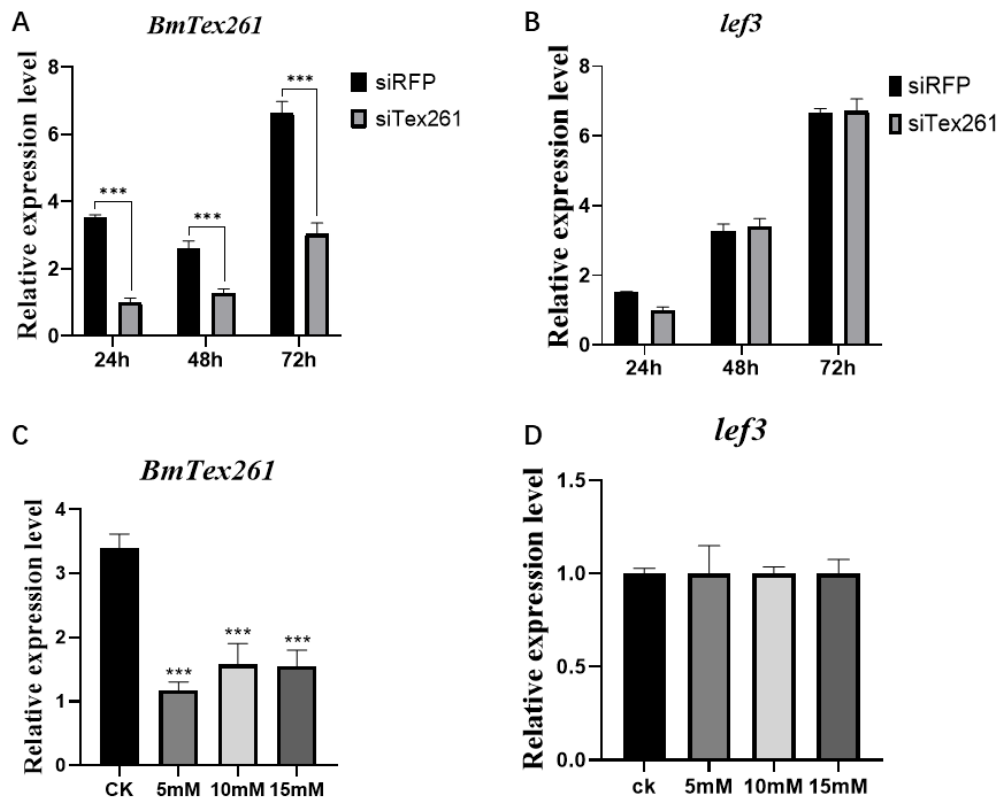
Figure 9. Analysis of AcMNPV infection after knocking down BmTex261 in BmN cells. ( A ) Expression analysis of BmTex261 after siTex261 transfection at different durations by using RT-qPCR. ( B ) Analysis of lef3 expression after knockdown of BmTex261 at different durations after AcMNPV infection. ( C ) Relative expression levels of BmTex261 after adding different concentrations of CaCl 2 ; ( D ) relative expression levels of lef3 after adding different concentrations of CaCl 2 . BmGAPDH was used to normalise the data that are shown as the mean ± standard error; the mean was obtained from three independent repeats. The 2 − ∆∆ Ct method was adopted to calculate the relative expression level. The statistical difference among three biological duplicates, determined with one-way ANOVA, is shown via graphpad prism. The level of statistical significance was set at ***, p < 0.001.